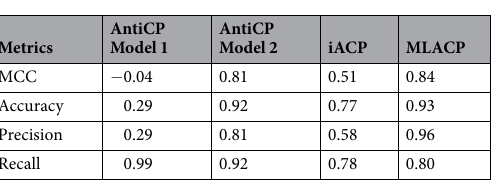
Table 2. Comparison of the model performance (Test score) with other online available ACP prediction tools calculated by using the independent test set. The Matthews correlation coefficient (MCC), accuracy, precision and recall were used as metrics (Methods Eqs